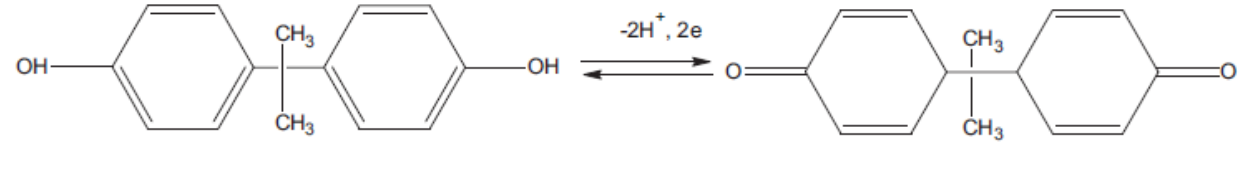
Figure 2. ( a ) Voltammograms for 1 µ mol L − 1 BPA in 0.01 mol L − 1 PBS solutions (pH 7.4) at different scan rates, ranging from 5 to 300 mV s − 1 using the FTO-(Chi/AuNPs) 3 . ( b ) Dependence of the oxidation and reduction peak current ( I p ) with the scan rate.